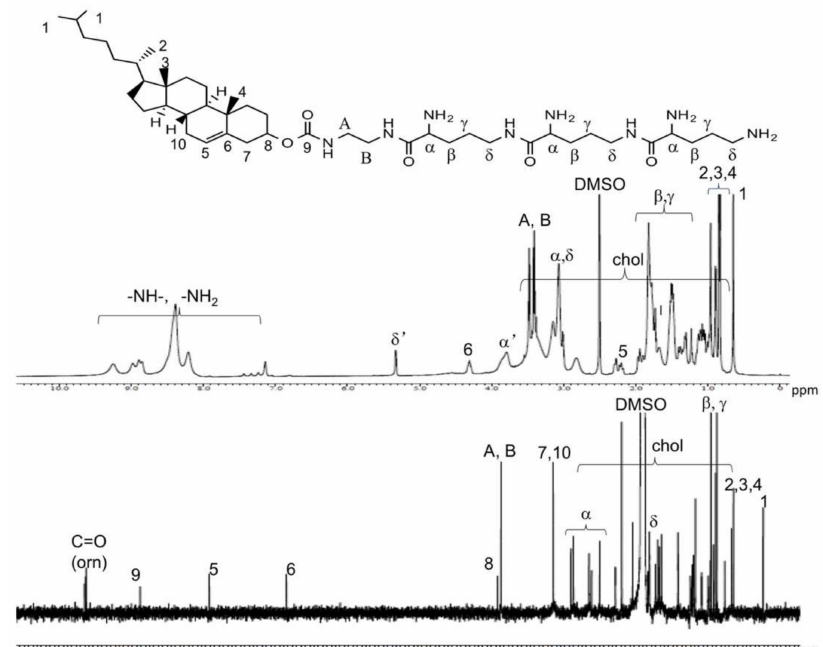
Figure 1. Characterization of Chorn3 lipid by 1 H-NMR ( upper ) and 13 C-NMR ( lower ) spectra in DMSO- d 6 .